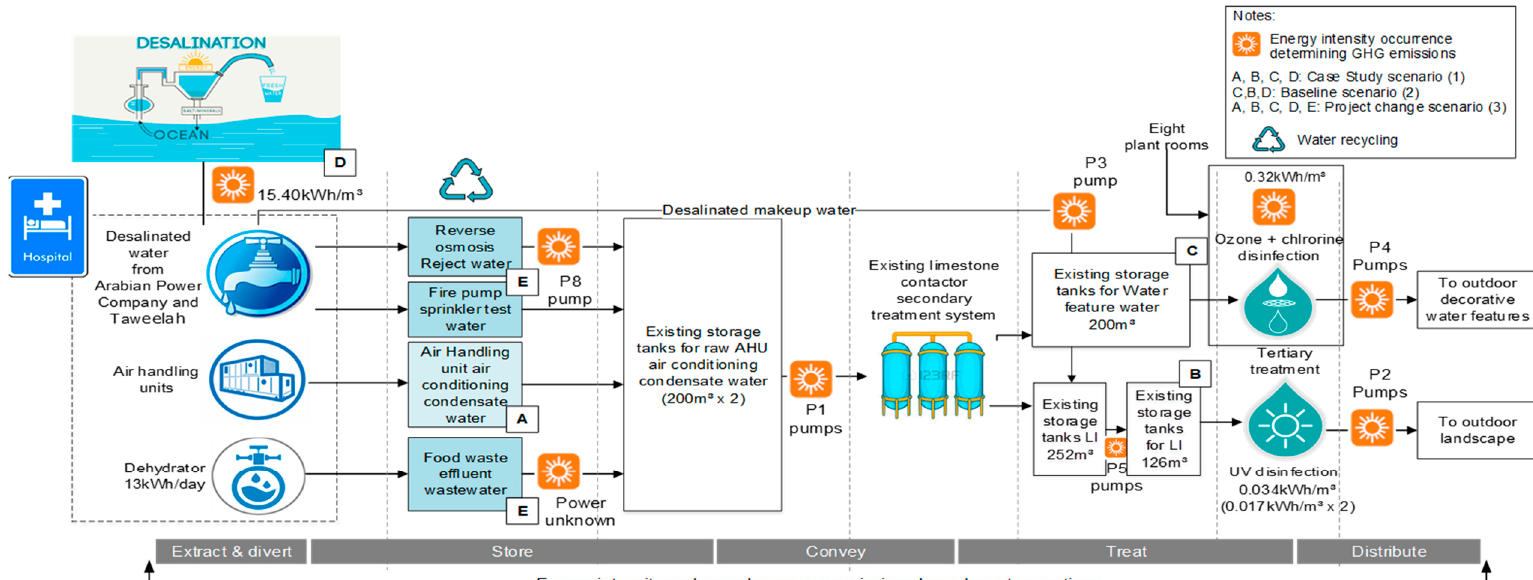
Figure A1. MFCS, S2, and PRP S3 calculation boundaries. Figure A1 is linked to Table A1 and the MFCS non-potable water system configuration diagram in Seguela [6] and Seguela et al. [51].